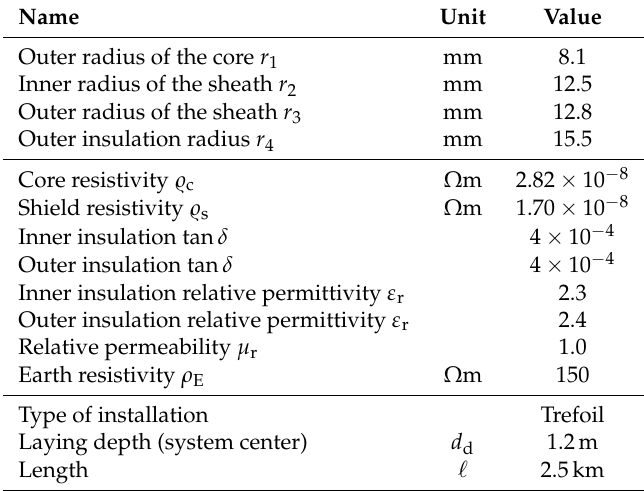
Table 1. Parameters of 10 kV cable,